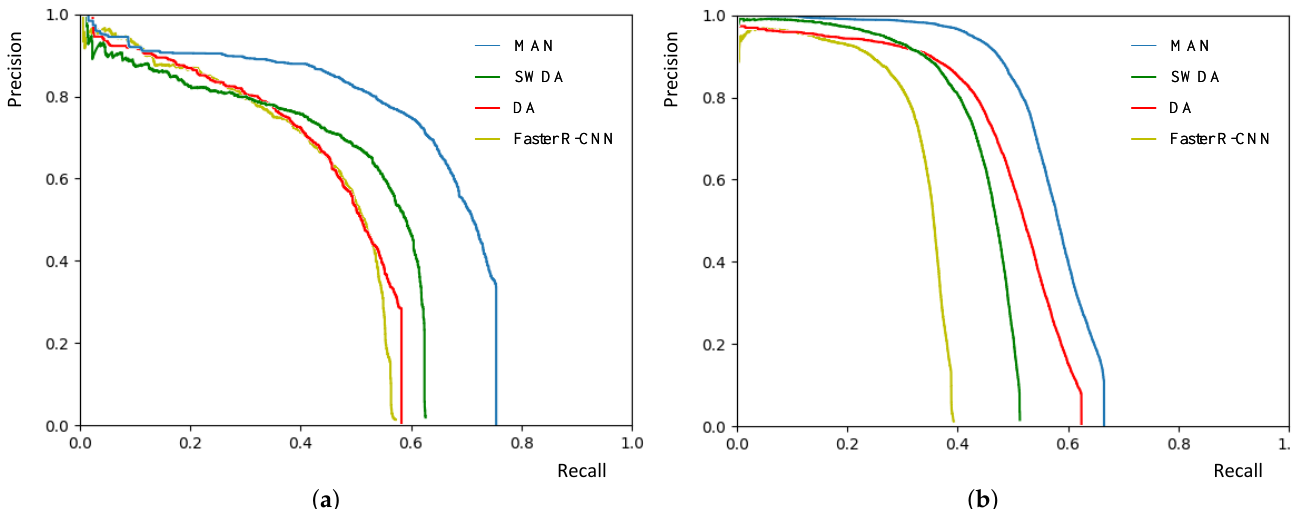
Figure 9. P-R curves of different detection methods. ( a ) HRRSD → SSDD dataset. ( b ) DIOR → HRSID